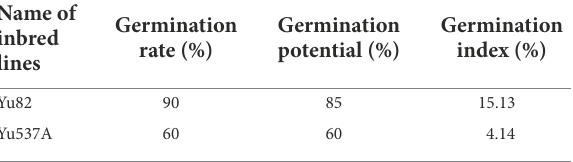
TABLE 1 Comparisons of germination between Yu82 and